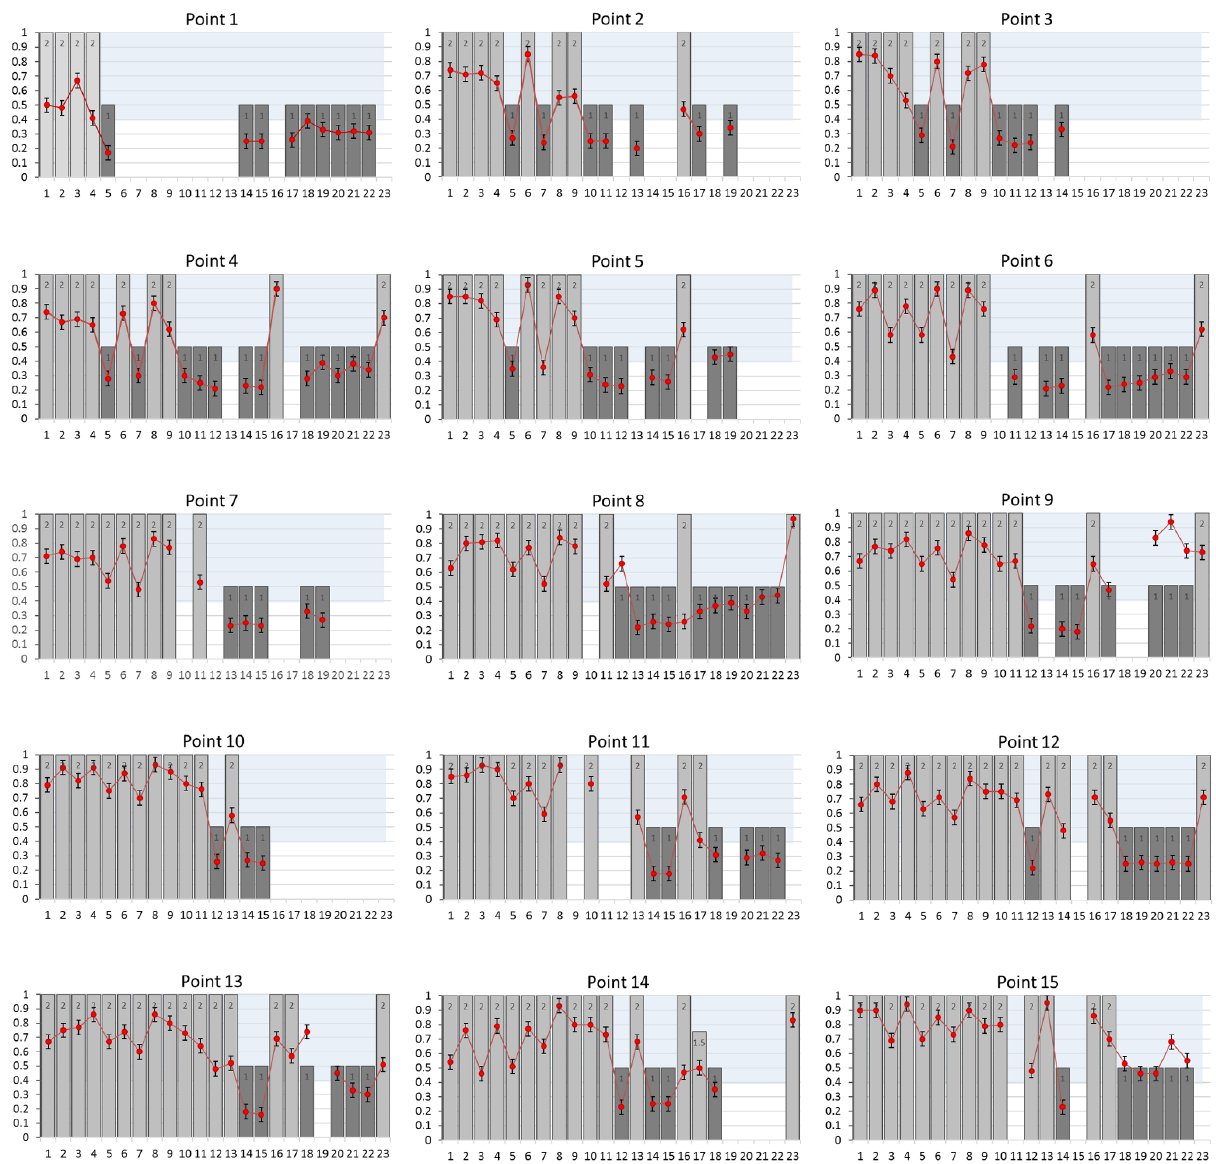
Figure 7. Comparison between the LCA measurements and the 23 LANDSAT images (from 18 October 2015 to 30 June 2016, the numbers for the x axis are the image numbers; see Table 2 for the correspondence) for the 15 points on the Zongo Glacier (see Fig. 5 for the locations of the LCA). The red points represent the albedo index value calculated with the LCA and the grey bars indicate the surface state for the corresponding pixel (1: ice and 2: snow). A value of 1.5 was chosen for stake number 14 as the pixel showed patchy snow cover.